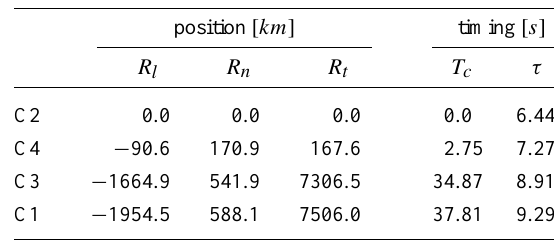
Table 2. Satellite relative positions and timing for the analyzed event. For each satellite the components along the l , h n i MVAB , and t directions (see the text) are provided, together with the MP central crossing time T c , and crossing duration τ . The C2 position is taken as origin of the reference frame and the T c quantities are computed with respect to the C2 central crossing